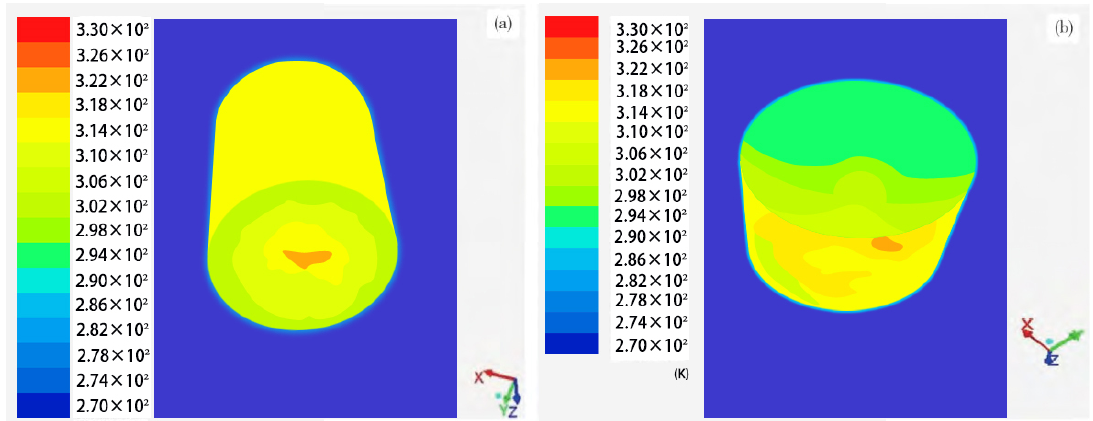
Figure 2. Temperature field in ( a ) normal and ( b ) extreme climate.